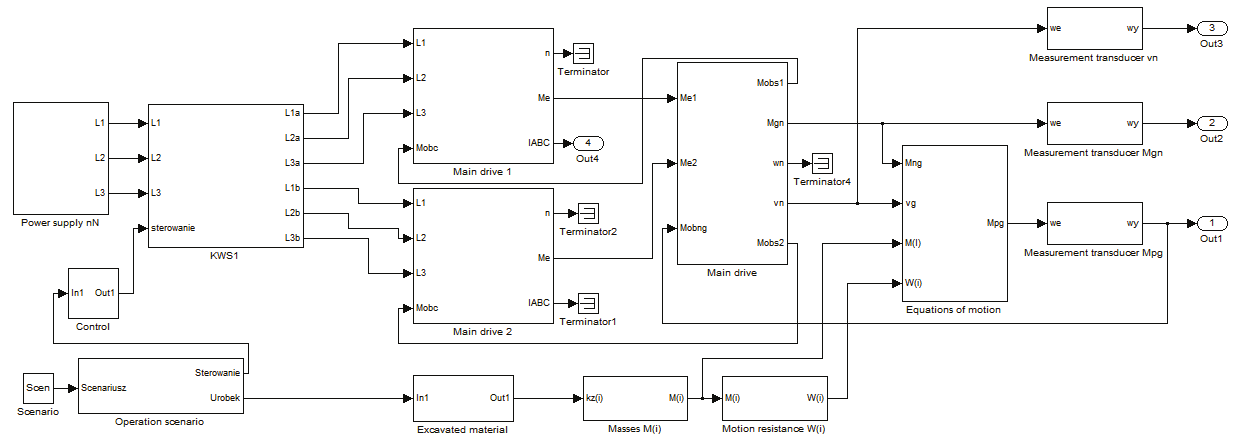
Fig. 5. Internal modular structure of a simulator of scraper